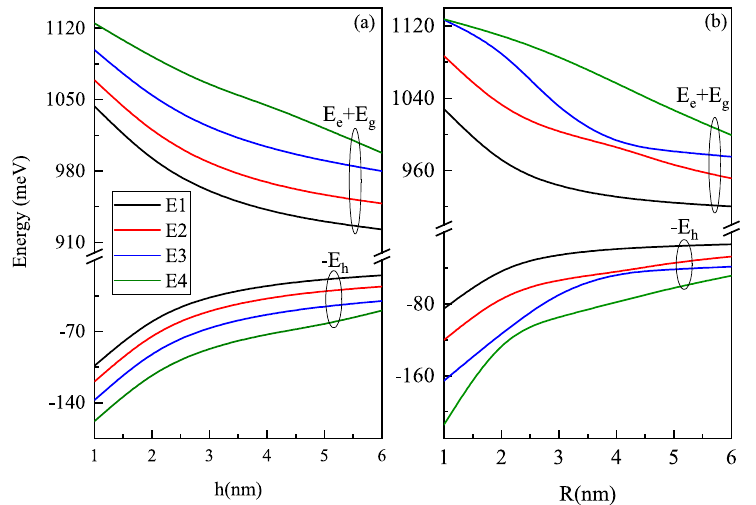
Figure 2. Variation of four low lying energy levels as a function of the ( a ) oblate QD height (with R = 7 nm) and ( b ) prolate QD R (with h = 7 nm) without electric field i.e., F = 0 kV/cm for electron and hole